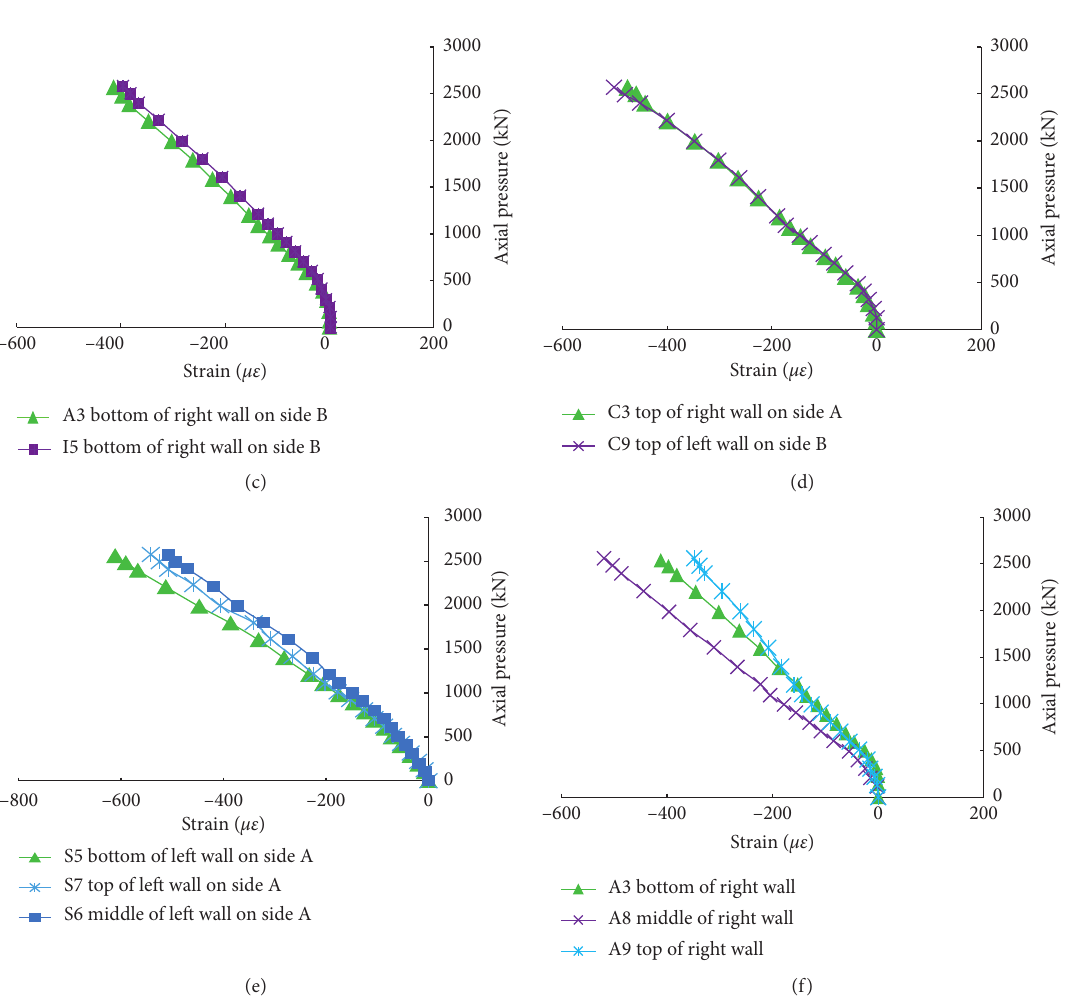
Figure 6: Strain variation of reinforcement. (a) Strain of the central grid reinforcement on the same side. (b) Strain of edge longitudinal bars. (c) Strain of grid reinforcement at corresponding positions on both sides. (d) Strain of grid reinforcement at corresponding positions on both sides. (e) Strain of edge longitudinal bars along the height. (f) Strain of grid reinforcement along height.